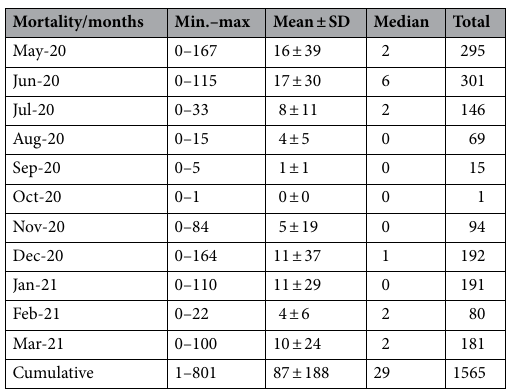
Table 2. COVID-19 mortality rate in Sudan.